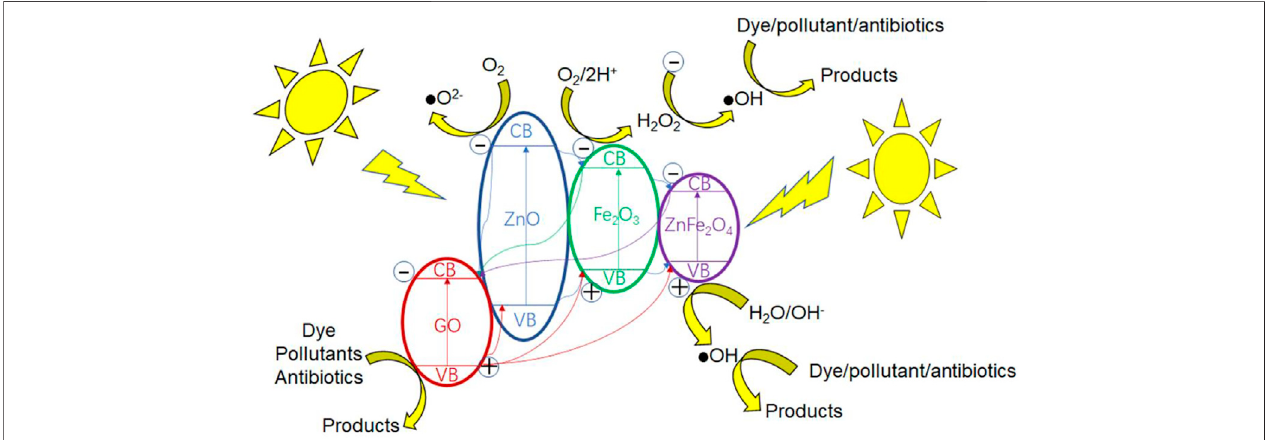
FIGURE 10 | Photocatalytic mechanism of